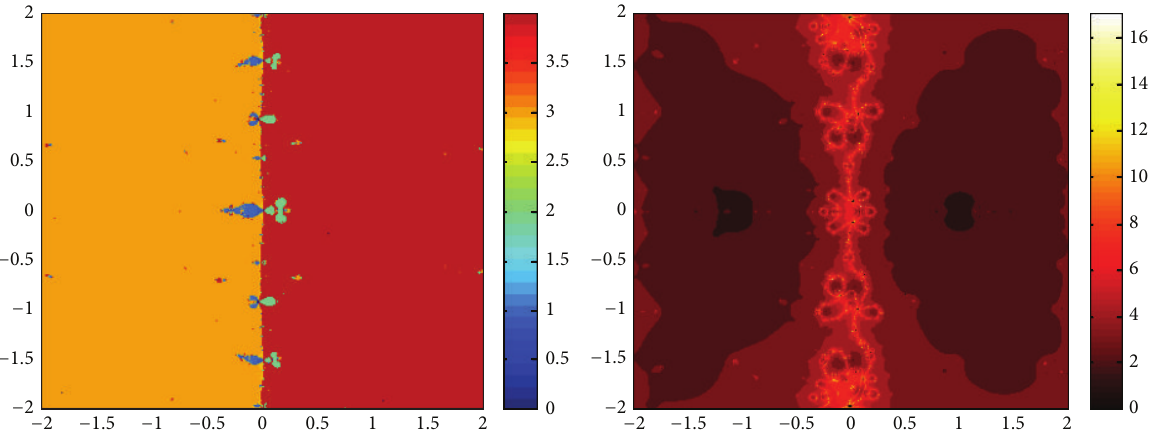
Figure 6: Basins of attraction of method (32) for 𝑝 4 (𝑥) .